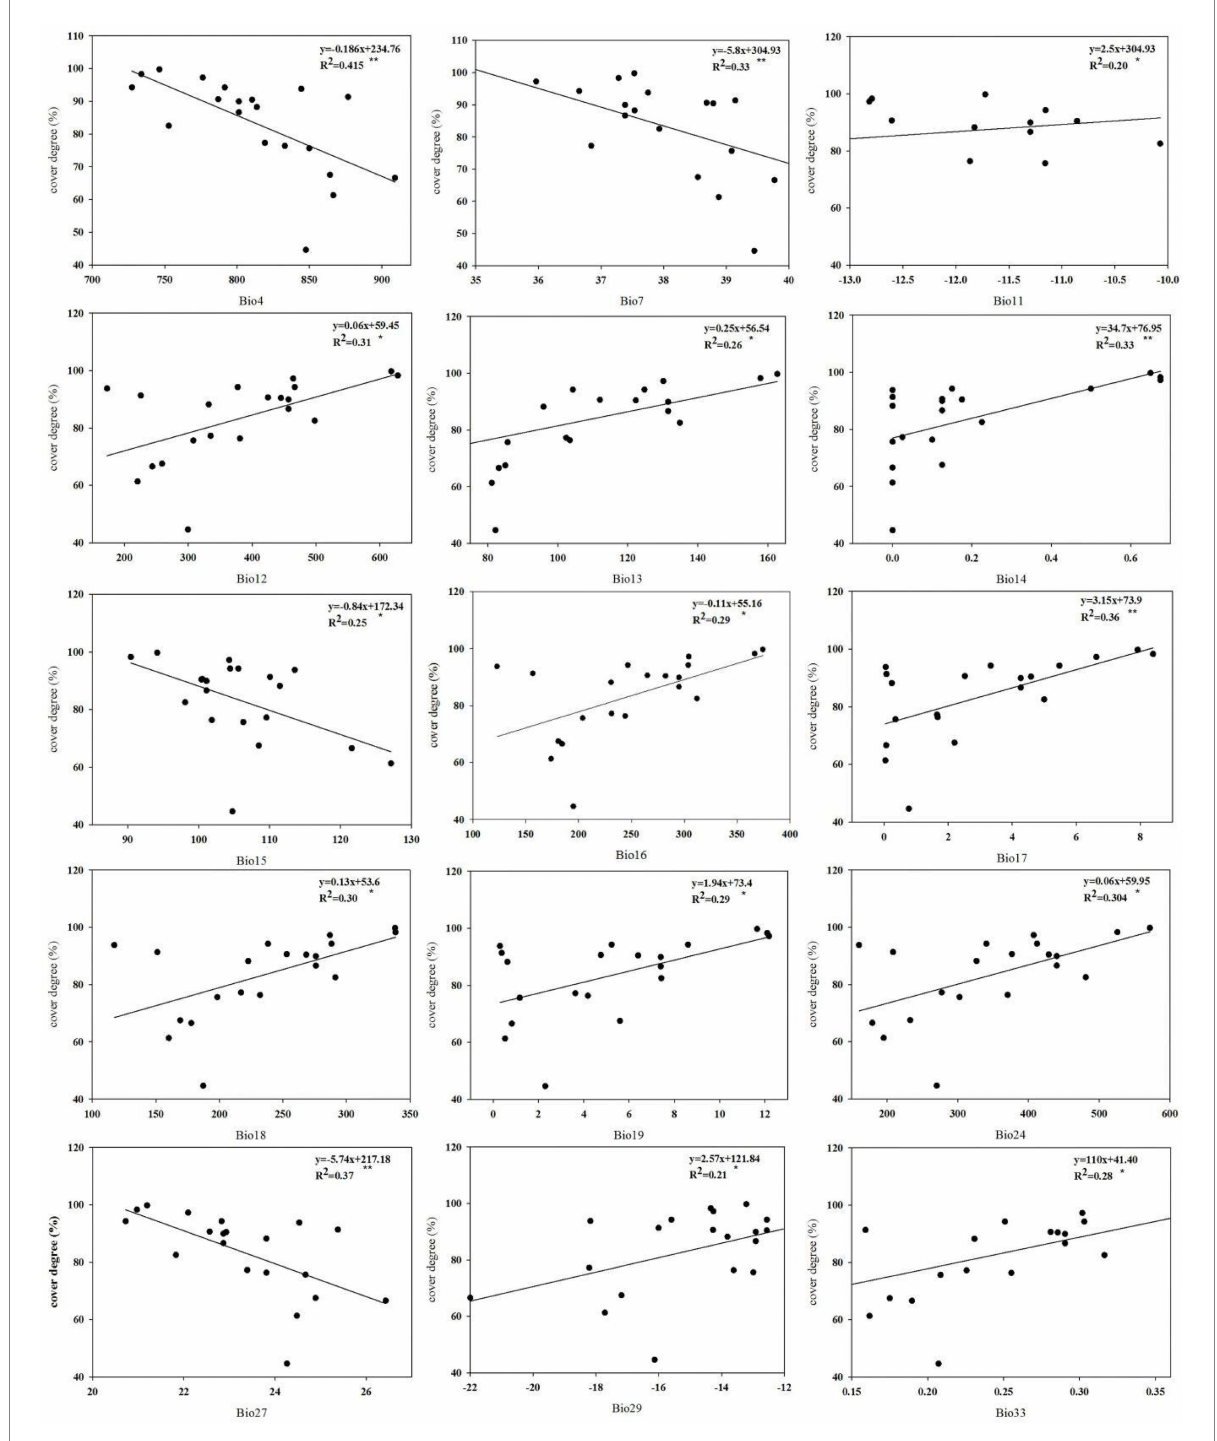
FIGURE 5 Relationship between forage coverage and 15 bioclimatic indices.